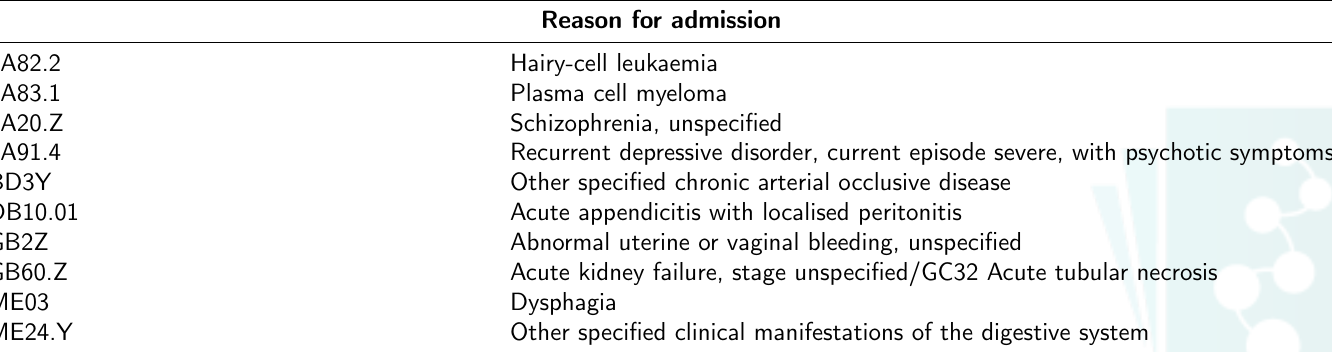
Table 4: Top 10 disagreeing conditions by ‘reason for